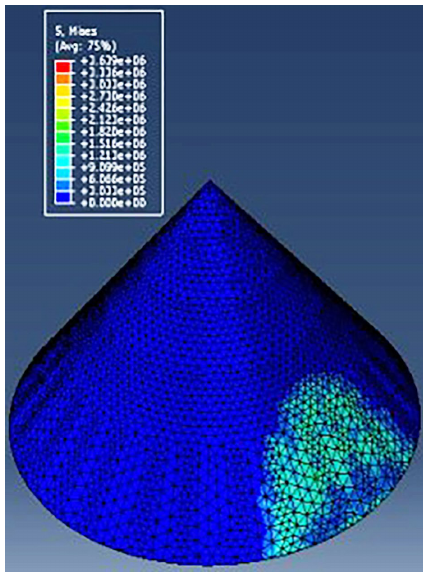
Fig. 15. Von misses composite stress contour in conical building while explosion strikes building at height of 10 meters above the roof